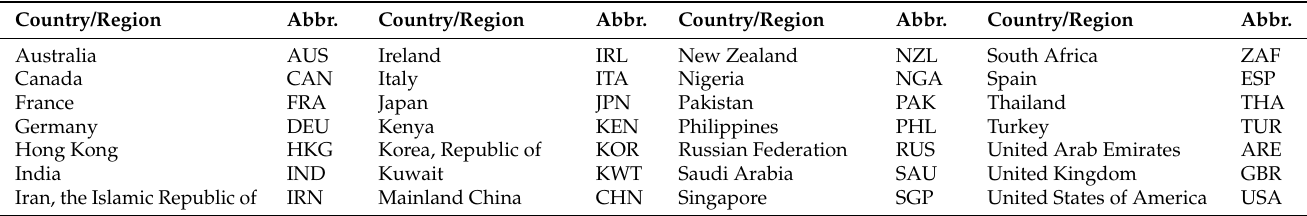
Table A1. Coding of